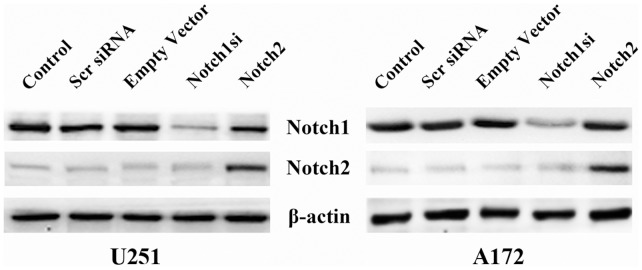
Expression of Notch1 and Notch2 in U251/A172 cells transfected with Notch1 siRNA or Notch2 construct by Western blot.Notch1/2 expression of U251/A172 cells transfected with Notch1 siRNA or Notch2 construct as shown by western blot.